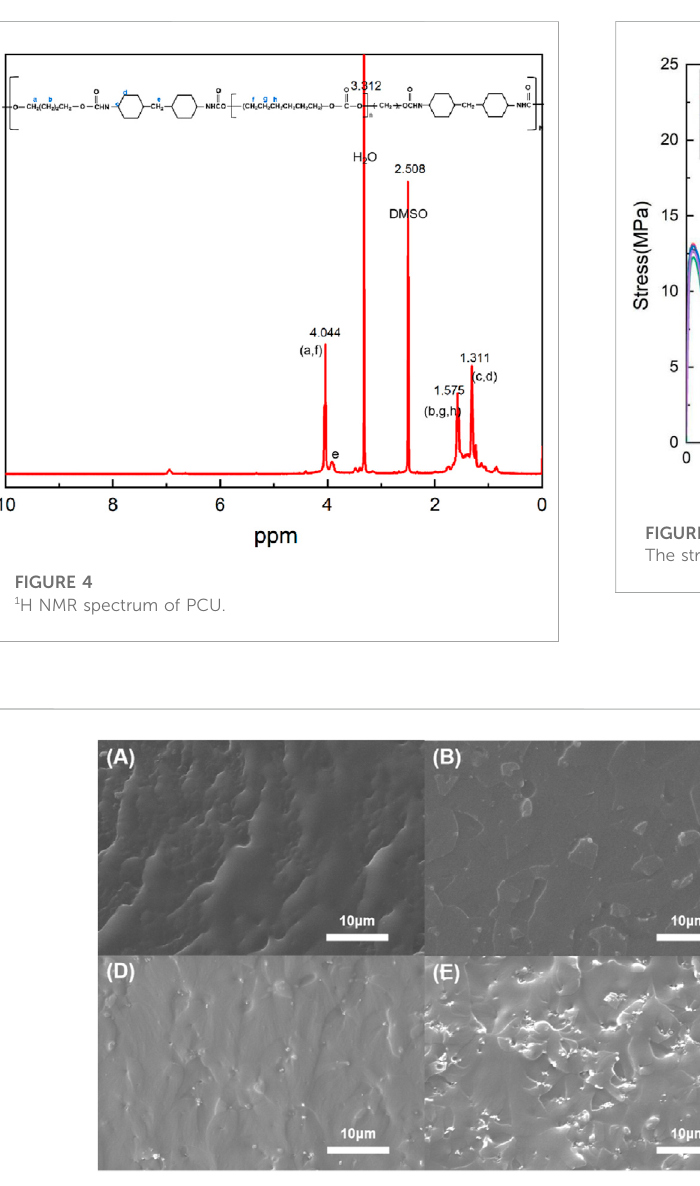
FIGURE 5 SEM images of (A) PCU/PPy-0, (B) PCU/PPy-0.1, (C) PCU/PPy-0.25, (D) PCU/PPy-0.5, (E) (F) PCU/PPy-1 (the scale bar of A,B,C,D,E,: 10 μ m and the scale bar of F: 5 μ m).